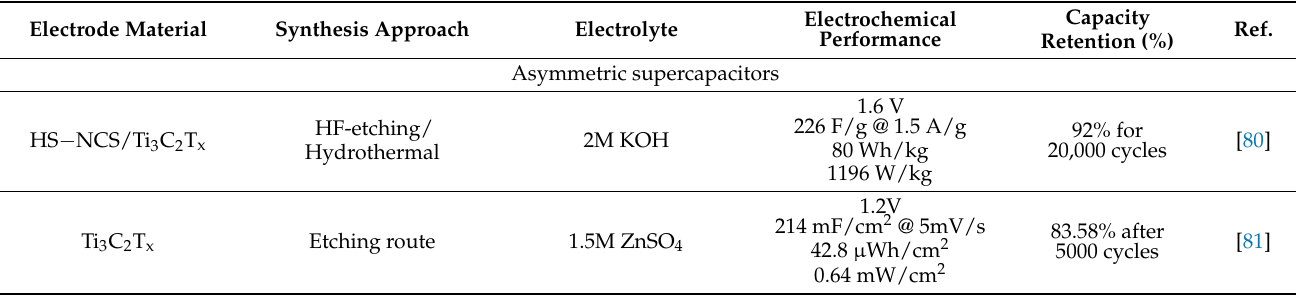
Table 2. Performance of MXene-based electrodes in